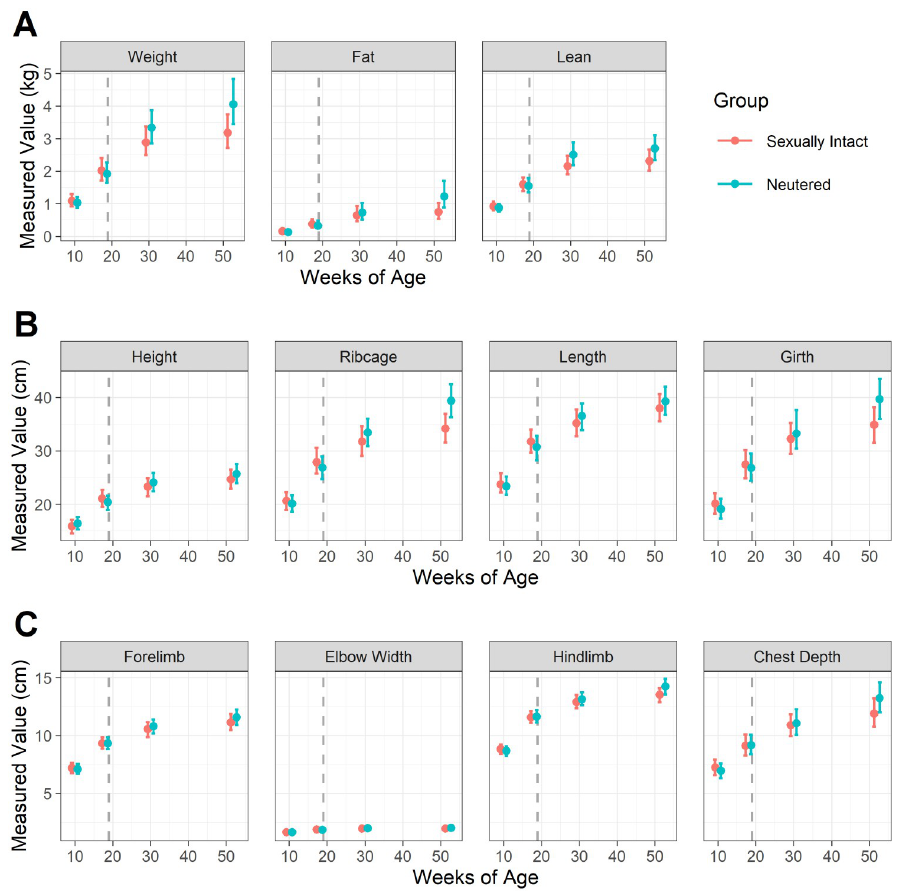
Fig 4. Estimated means and simultaneous 95% credible intervals for each measure, for each group and timepoint, shown on the original scales. The 11 sexually-intact cats are shown in red, whilst the 11 paired cats that were neutered are shown in blue; the grey dashed line indicates age of neutering. Panel A shows mass measurements, whilst and panels B and C show zoometric measurements. Weight, fat mass and lean mass measured by dual-energy X-ray absorptiometry (Hologic QDR-1000 W; Hologic, Inc., Waltham, MA, USA); height measured at the points of the scapula; ribcage measured at the deepest part of the thorax; length measured from manubrium of the sternum to a parallel point below the anus; girth measured around the narrowest point of the waist; forelimb bone measured from olecranon to carpus; elbow width, measured across the humeral condyles; hindlimb bone measured from patella to tarsus; chest depth measured mid-thorax from spine to the deepest